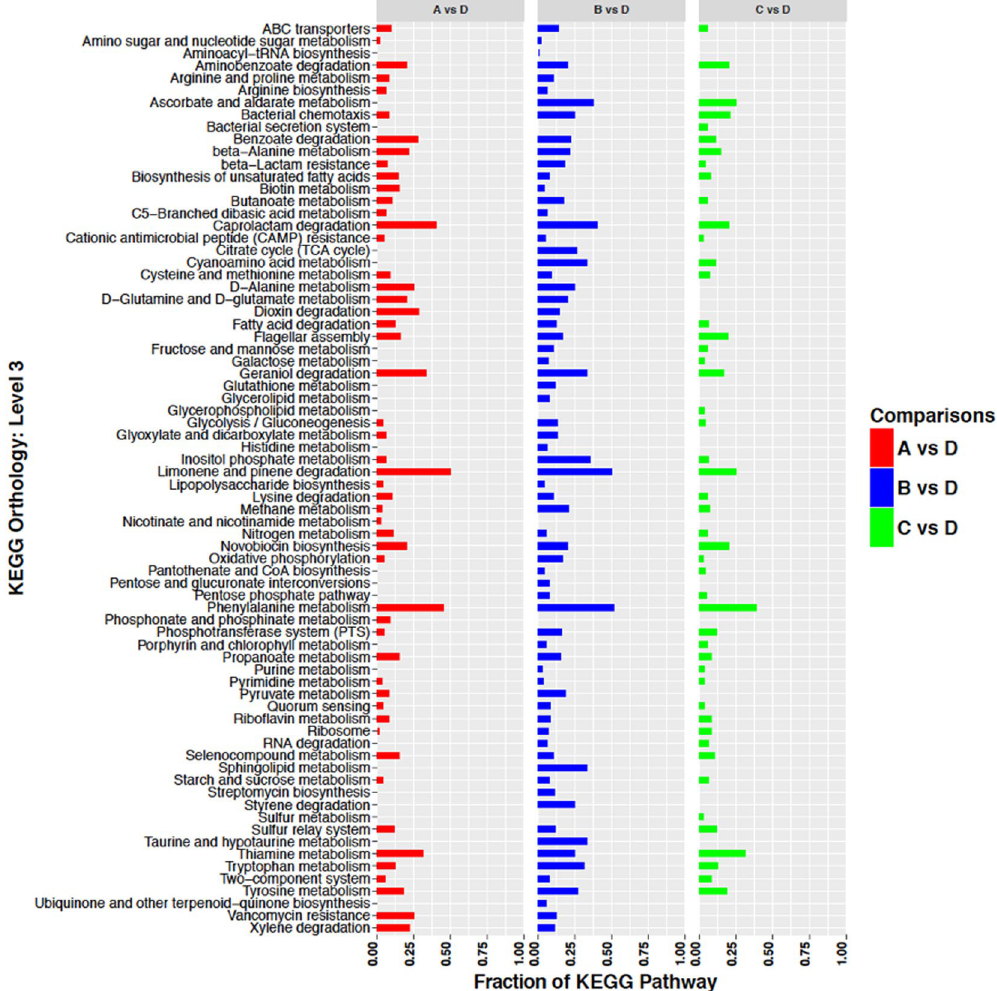
Figure 5. Down-regulated genes sorted by KEGG orthology. The number of genes of a particular KEGG pathway are depicted as a fraction of the total number of genes classified in that pathway in the genome of S. liquefaciens . See Table 1 for description of the